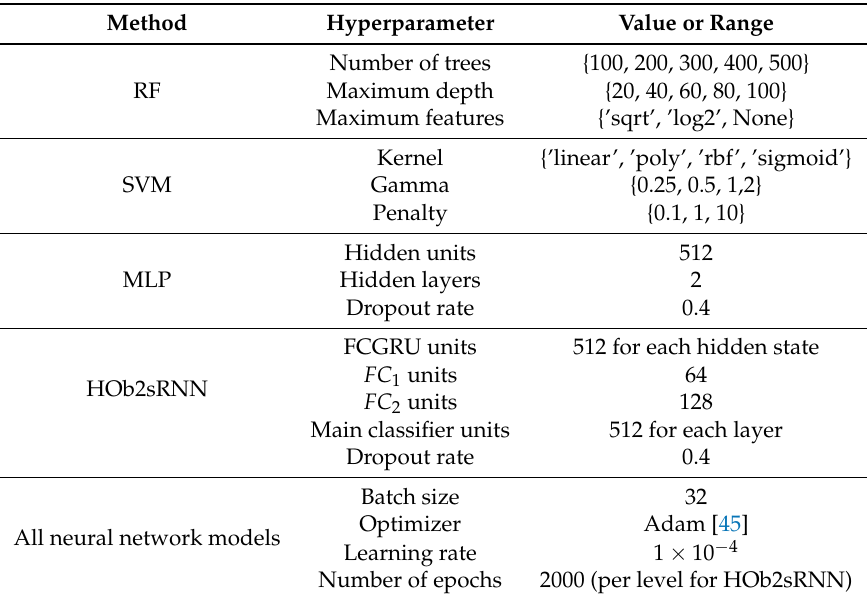
Table 4. Hyperparameter settings of the competing methods. RF and SVM method hyperparamaters were optimized by varying associated values while MLP, TempCNN, OD2RNN and HOb2sRNN model hyperparameters were empirically